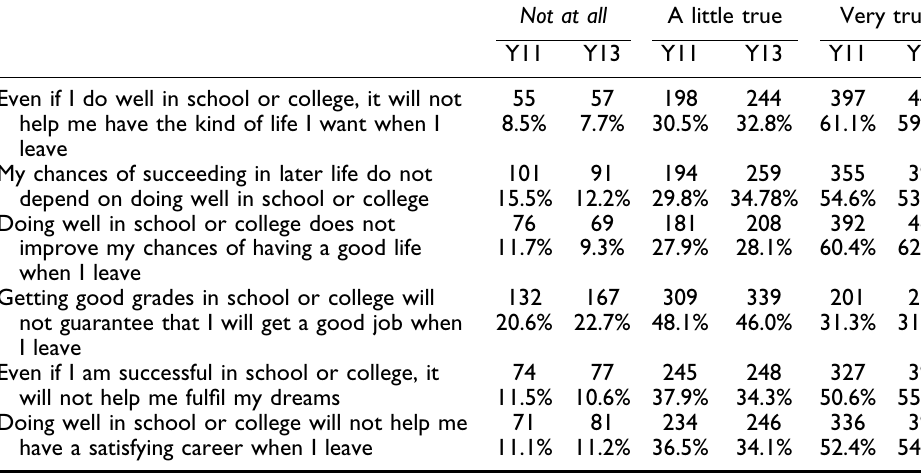
Table 5. Frequencies of responses to the survey items on the link between education and career, taken from ‘Scepticism about relevance of school for future success’ subscale of the Patterns of Adaptive Learning Survey (Midgeley et al. 1998).